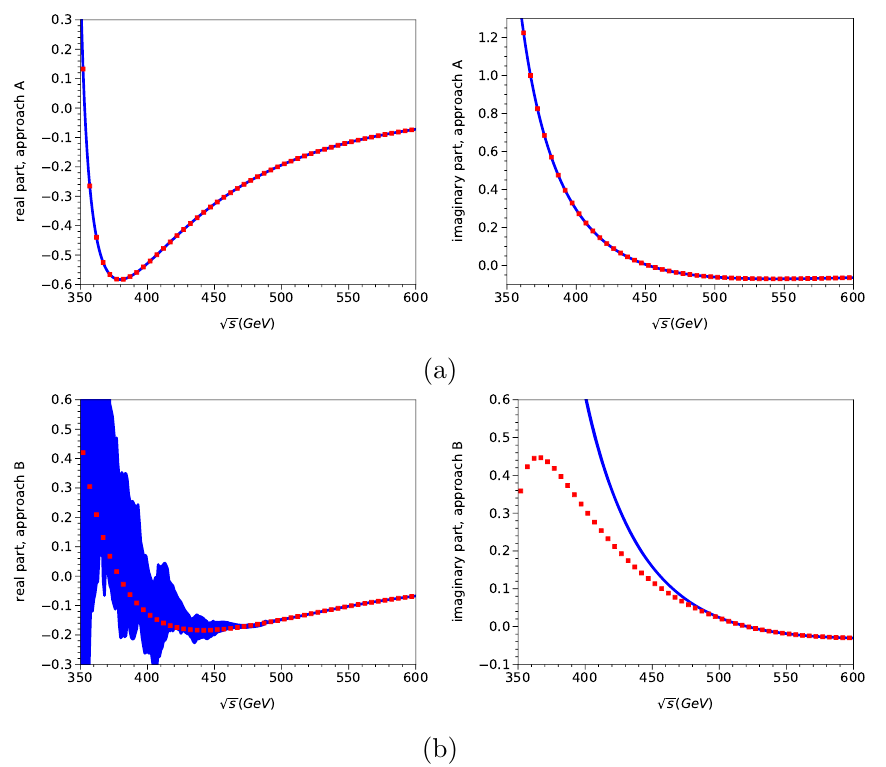
Figure 7 . Real and imaginary parts of the seven-line master integral (see figure 6) for p T = 120 GeV. Top: the line in the middle is massless; bottom: all lines are massive. Numerical results from FIESTA are shown in red; Padé results together with the corresponding uncertainty band are shown in